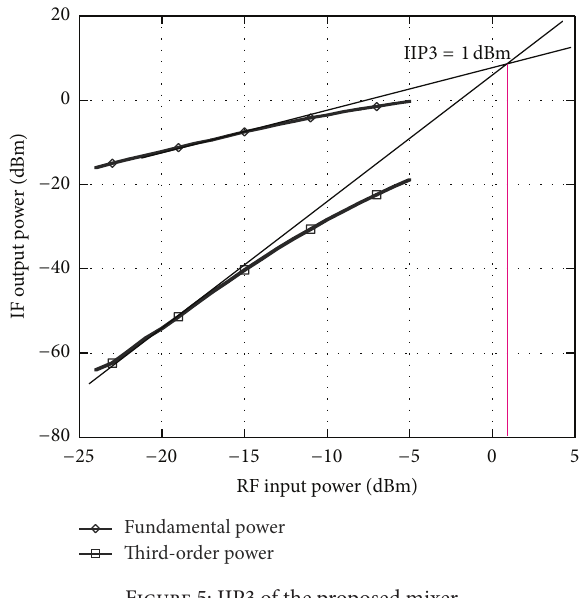
Figure 5: IIP3 of the proposed mixer.